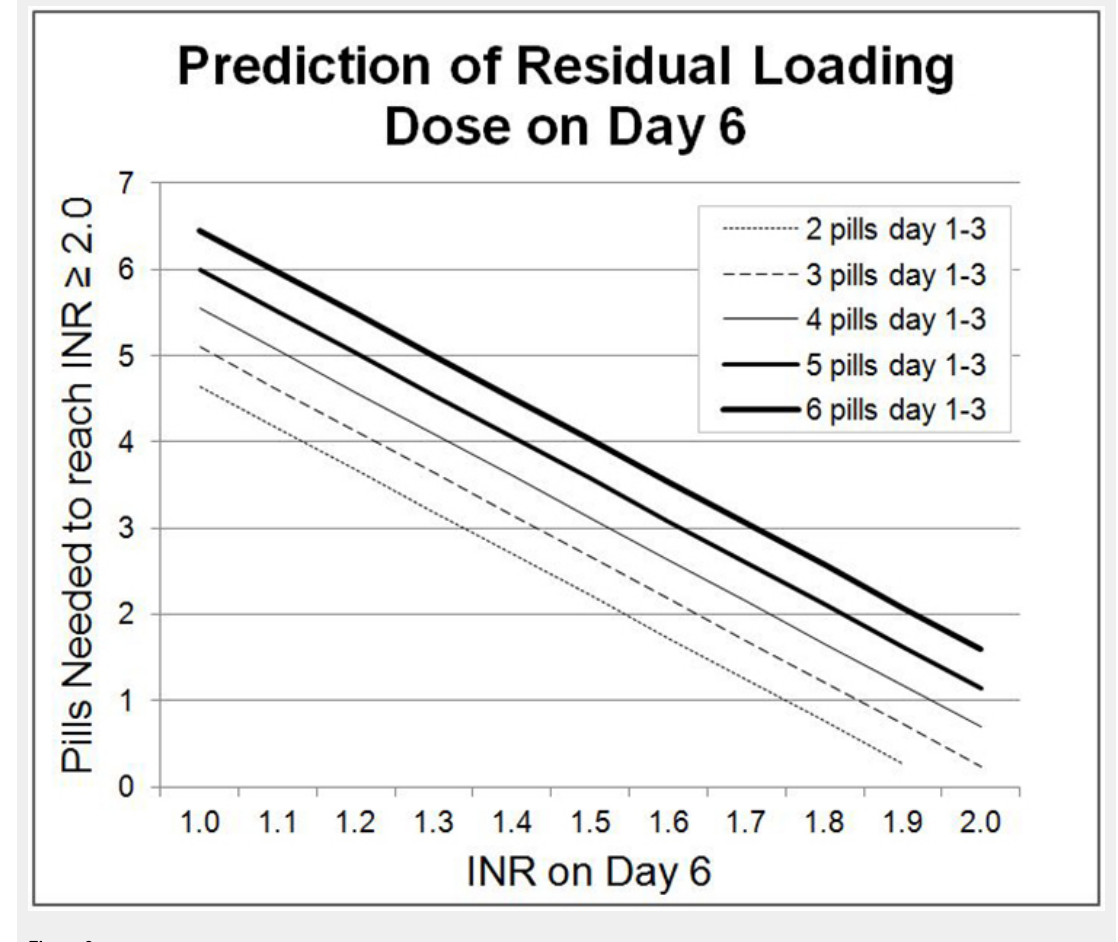
Figure 3 Prediction of residual loading dose on days 4 and